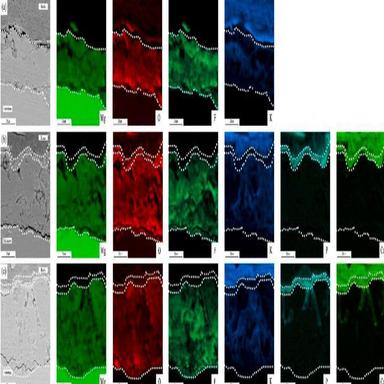
Cross-sectional morphologies and element distributions of the (a) AO sample, (b) ED sample, (c) ST sample.